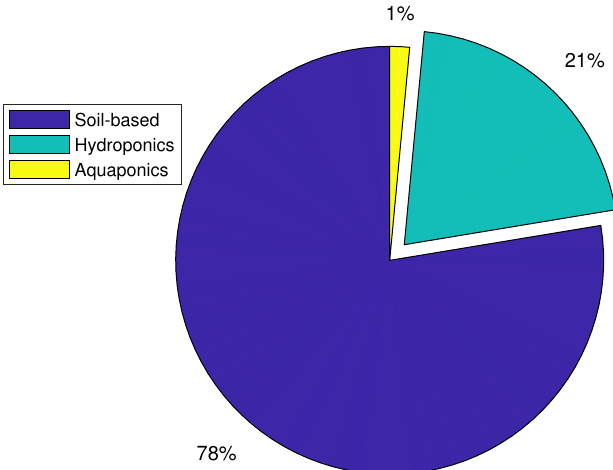
Figure 13. The percentages of papers that planted lettuce, pepper, and cucumber are 16%, 9%, and 8%, respectively. According to the reviewed publications, it was also discovered that indoor farms used soil-less techniques (hydroponics and aquaponics) more frequently than greenhouse systems, which frequently used soil-based growing medium.